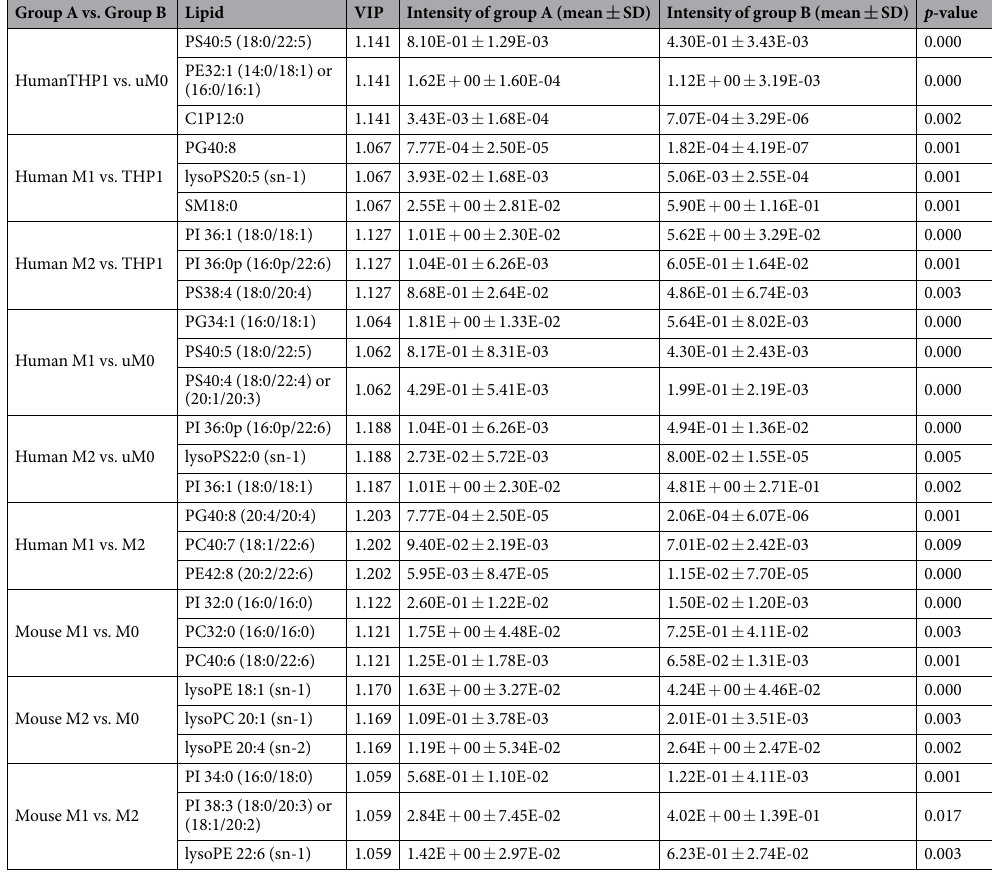
Table 1. Lipid markers for distinguishing macrophages in different